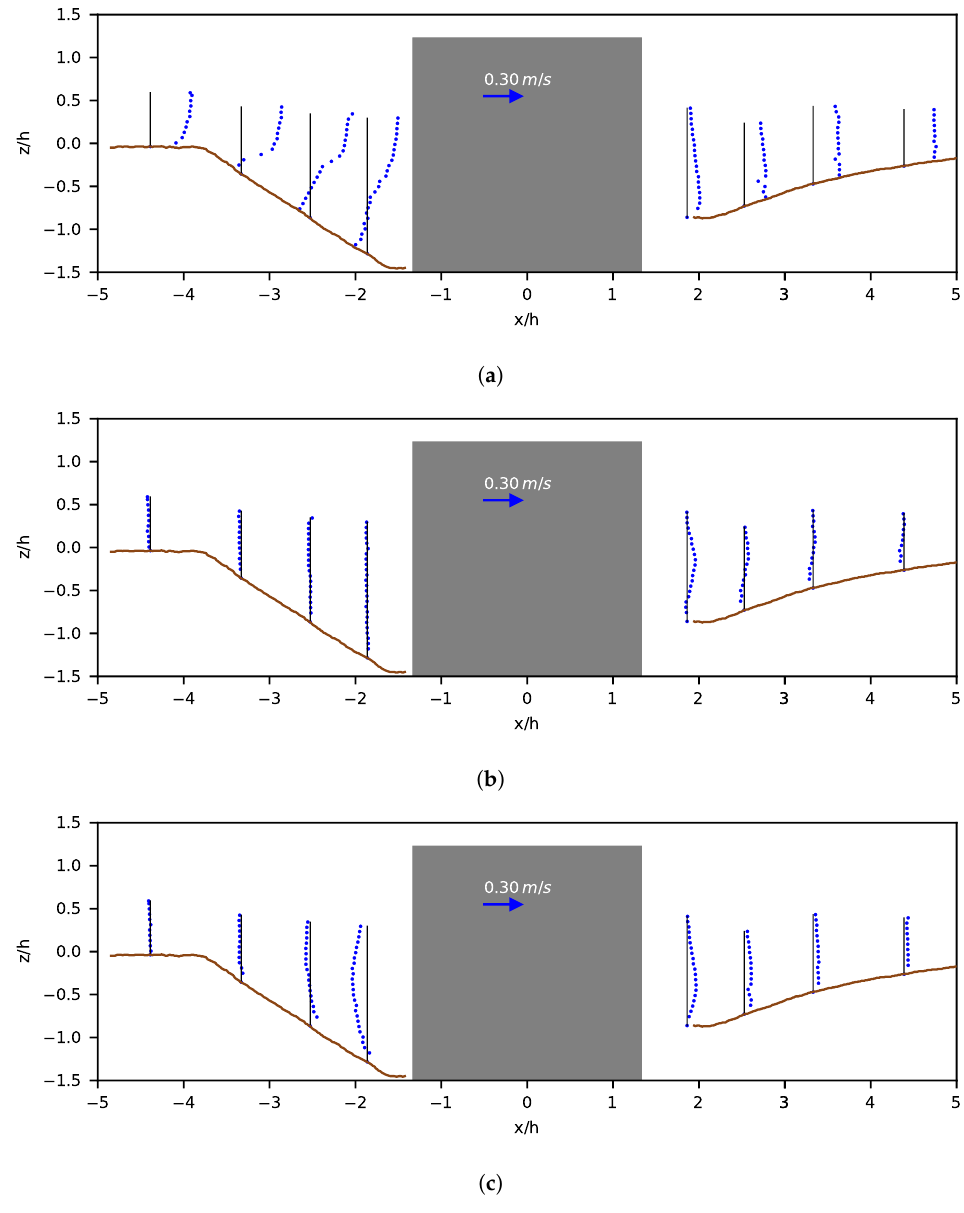
Figure 10. Vertical profiles of the velocity components along the pier’s mid-plane for Exp . 1 U Ebed . ( a ) Stream-wise component of velocity ( u ). ( b ) Cross-wise component of velocity ( v ). ( c ) Vertical component of velocity ( w